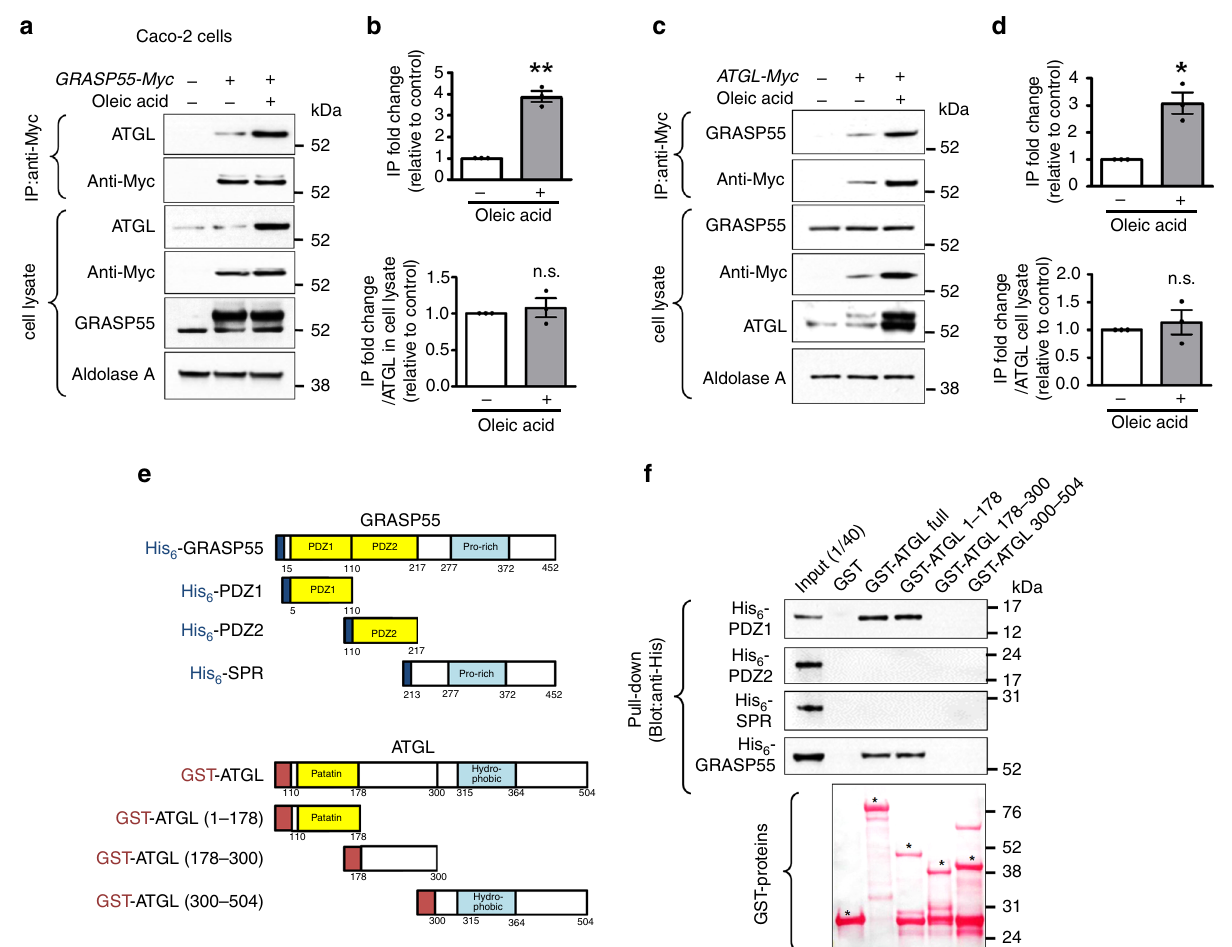
Fig. 7 GRASP55-PDZ1 interacts with ATGL-patatin. a – d Coimmunoprecipitation experiments with anti-Myc antibodies were performed in Caco-2 cells. For the induction of ATGL protein expression, some cells were treated with 400 μ M oleic acid for 16 h. A representative coimmunoprecipitation assay using GRASP55 with a COOH-terminal Myc-tag ( GRASP55-Myc ) is shown in ( a ), and the results of multiple experiments are summarized in ( b , n = 3). A representative coimmunoprecipitation assay using ATGL with a COOH-terminal Myc-tag ( ATGL-Myc ) is shown in ( c ), and the results of multiple experiments are summarized in ( d ) ( n = 3). Aldolase A was used as a cytosolic protein loading control. e , f Pull-down assays were performed with GRASP55 and ATGL fragments. The domain structures of His 6 -tagged GRASP55 and GST-tagged ATGL constructs used in this study are shown in ( e ), and a representative result from the pull-down assay is shown in ( f ). Expression of control GST and each GST-fusion protein is visualized by Ponceau S staining ( f lowermost panel). An asterisk indicates the band of each GST-tagged protein. One microgram of each His 6 -tagged protein was loaded as an input control. The PDZ1 domain of GRASP55 interacted strongly with the ATGL-patatin domain. Three independent experiments showed similar results. Unprocessed blots can be found in Supplementary Fig. 22. Data are shown as mean ± SEM. n.s.: not signi fi cant, * p < 0.05, ** p < 0.01. All p values were calculated by paired two-tailed Student ’ s t tests. Source data are provided as a Source Data fi